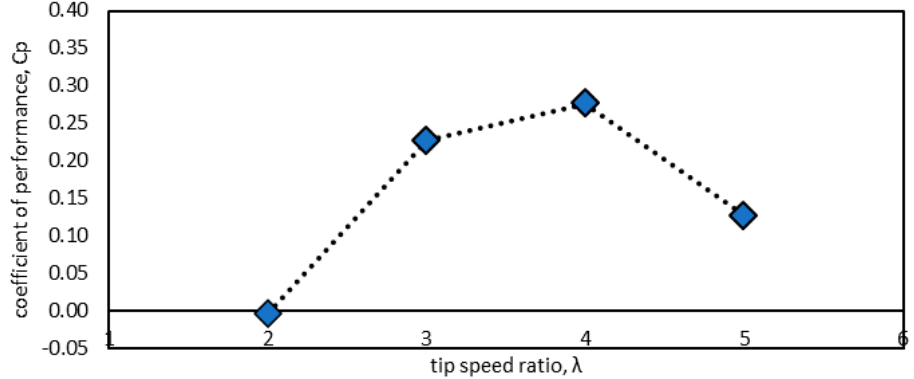
Figure 6. Cp curve of λ = 2, 3, 4 and 5 at 2° temporal resolution.